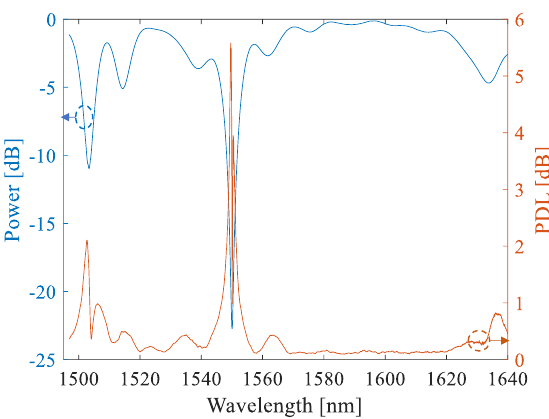
Fig. 5 . PDL and insertion loss of the fibre